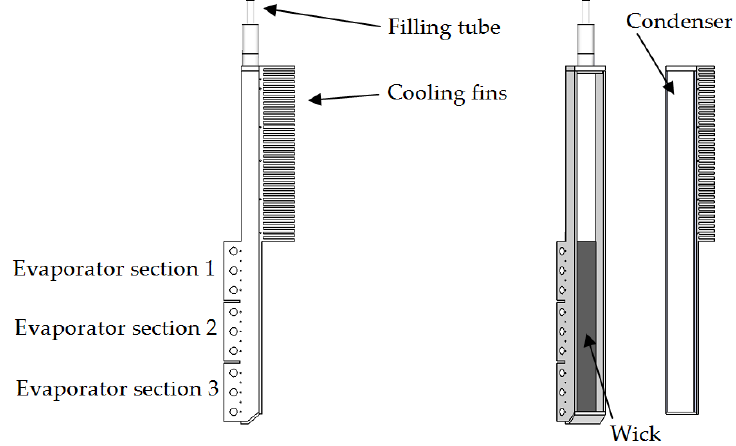
Figure 2. The experimental heat pipe fully assembled ( left ) and split in two ( right ).